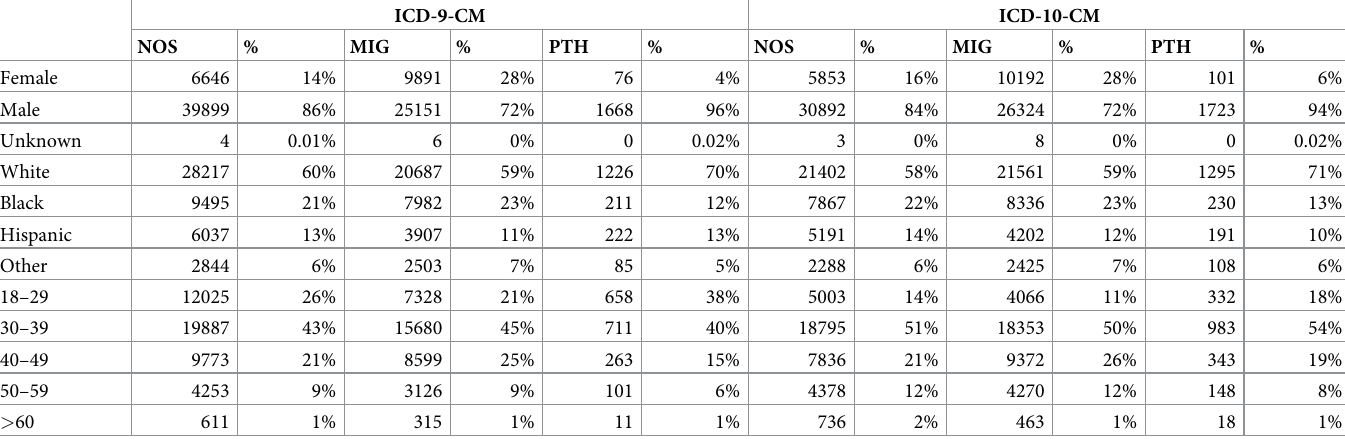
Table 4. Changes in headache coding across different sociodemographic groups.